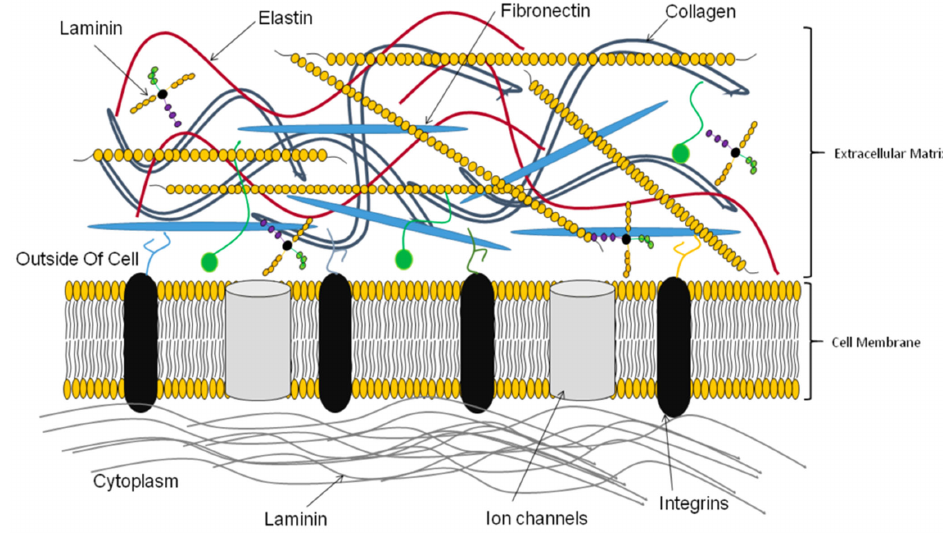
Figure 2. Various ECM components [68] .